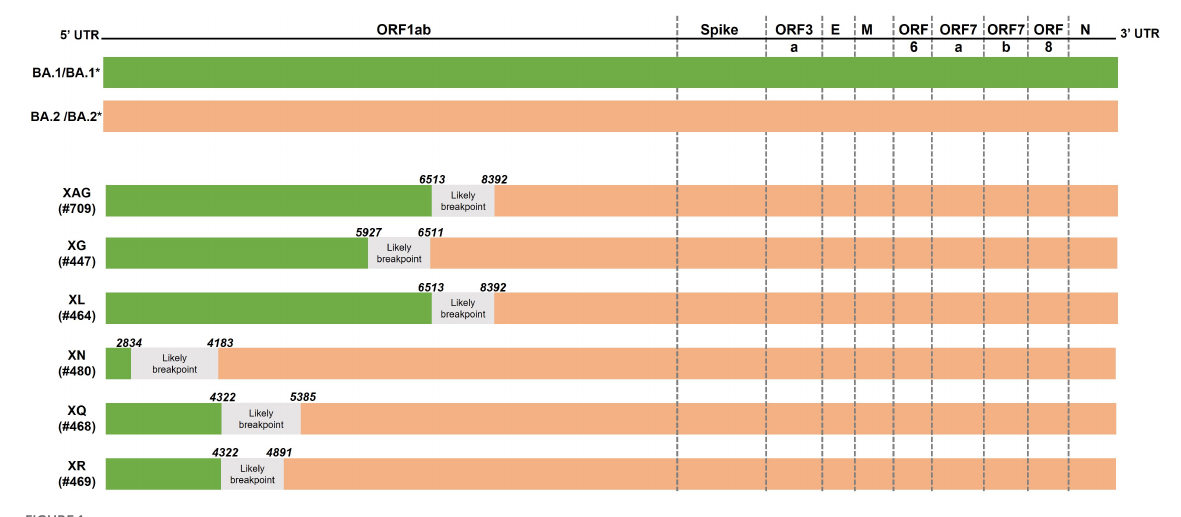
FIGURE1 Schematic representation of recombination points. Schematic of the SARS-CoV-2 genome (upper panel) and positions where possible recombination points occur in the XAG, XG, XL, XN, XQ, and XR recombinants (lower panel) .